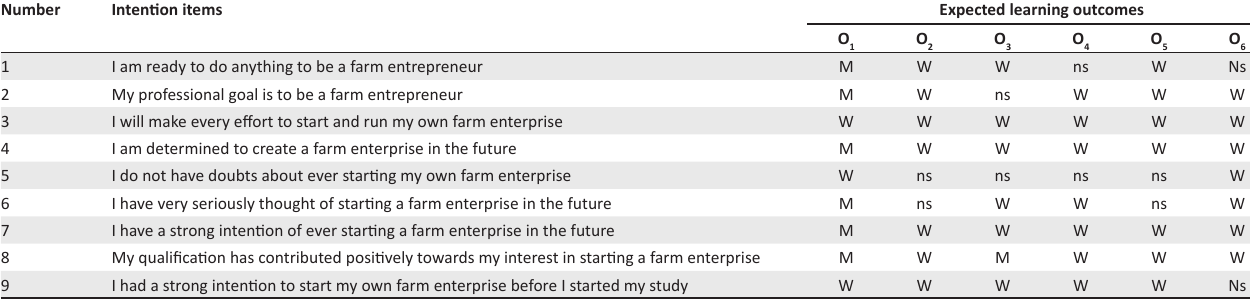
TABLE 9: The relationship between farm entrepreneurial intention and expected learning outcomes. Number Intention